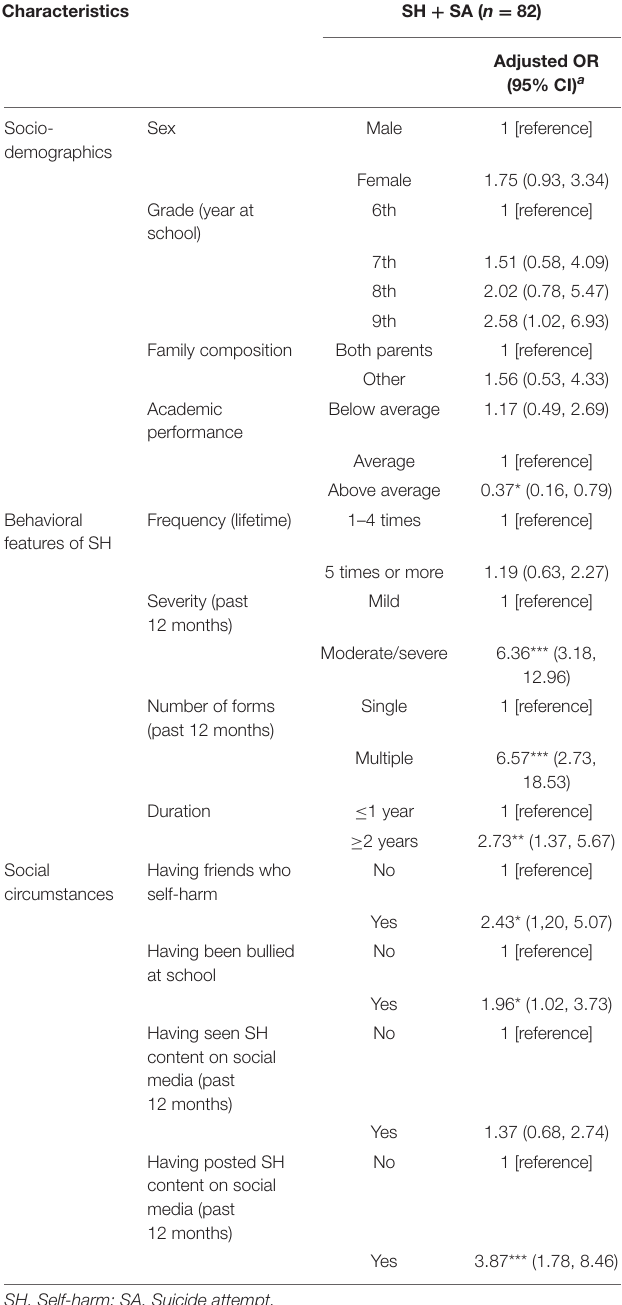
TABLE 4 | Multivariate logistic regression for lifetime SA ( n = 846).